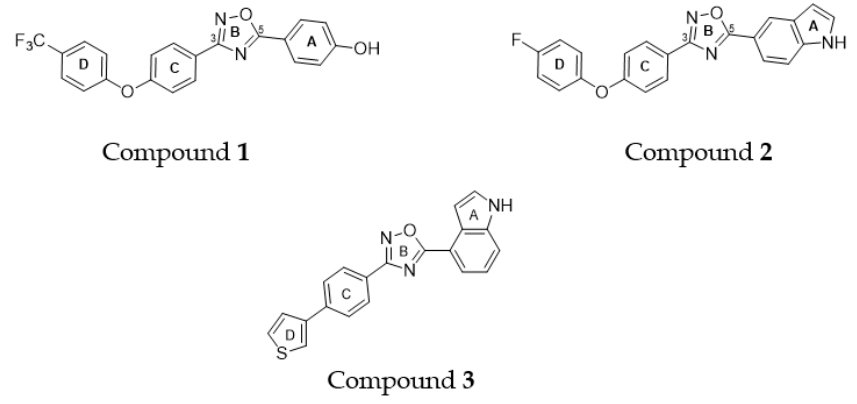
Figure 2. Structures of previously synthetized oxadiazoles ( 1 – 3 ).